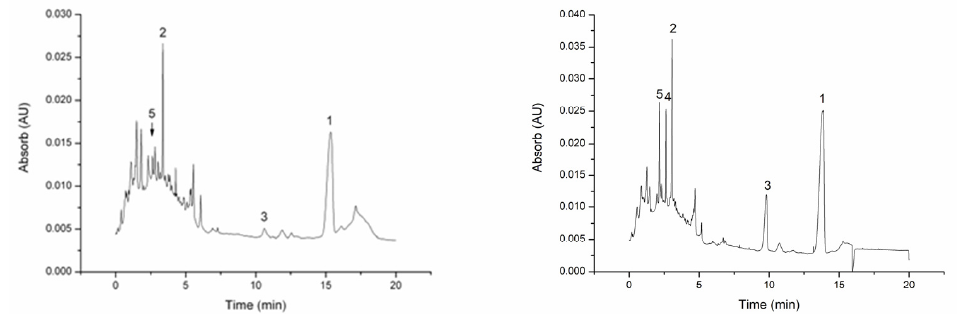
Figure 8. Electropherograms of Cibotium barometz nonspiked (left) and spiked (right). Running buffer: 10 mM sodium dodecyl sulfate and 50 mM sodium borax-sodium dihydrogen phosphate − 10% methanol